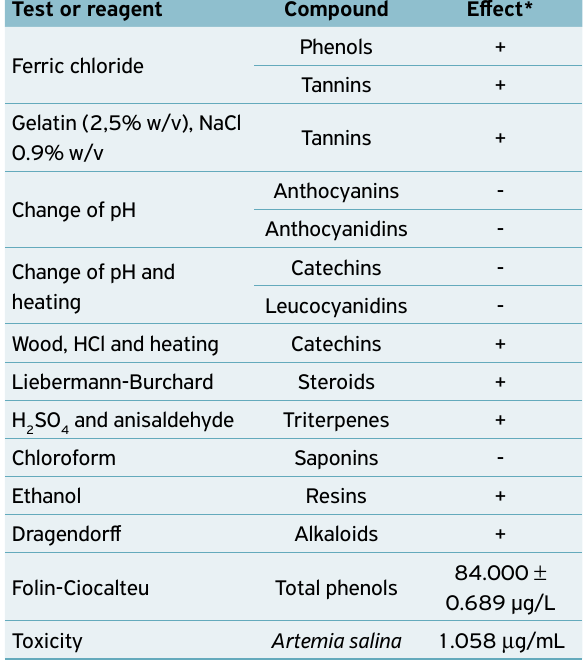
Table 2. Result from phytochemical screening of the hydroalcoholic extract obtained from the plant Chenopodium ambrosioides .